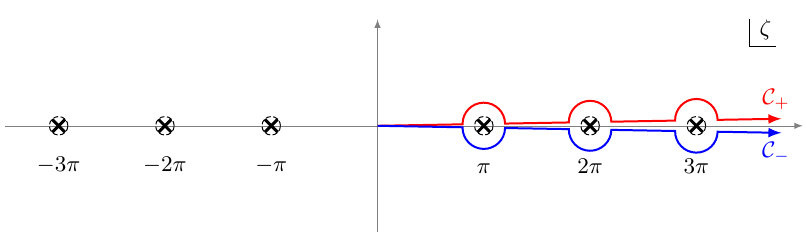
Figure 2 . Pole structure and integration contours C ± for the lateral Borel transform of the trace of the heat kernel on S 2 . The two choices differ by the residues at y = kπ , k = 1 , 2 , . . . .